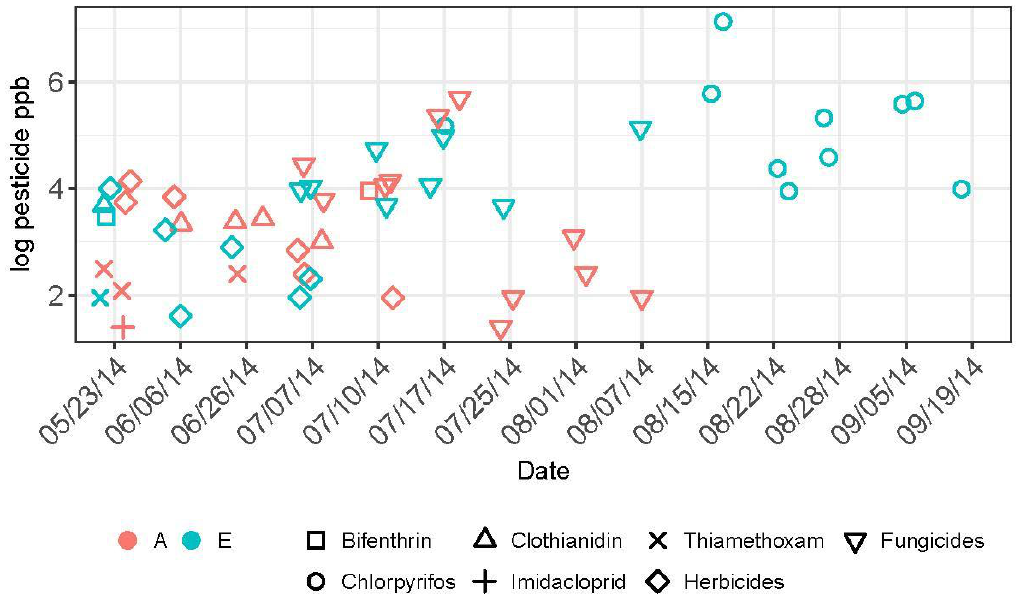
Figure 6. Temporal occurrence of detected pesticide residues over the growing season in pollen collected by honey bee colonies at apiary sites A and E in 2014. The jitter function was applied to improve visual discernment of individual pesticide detections on each date.